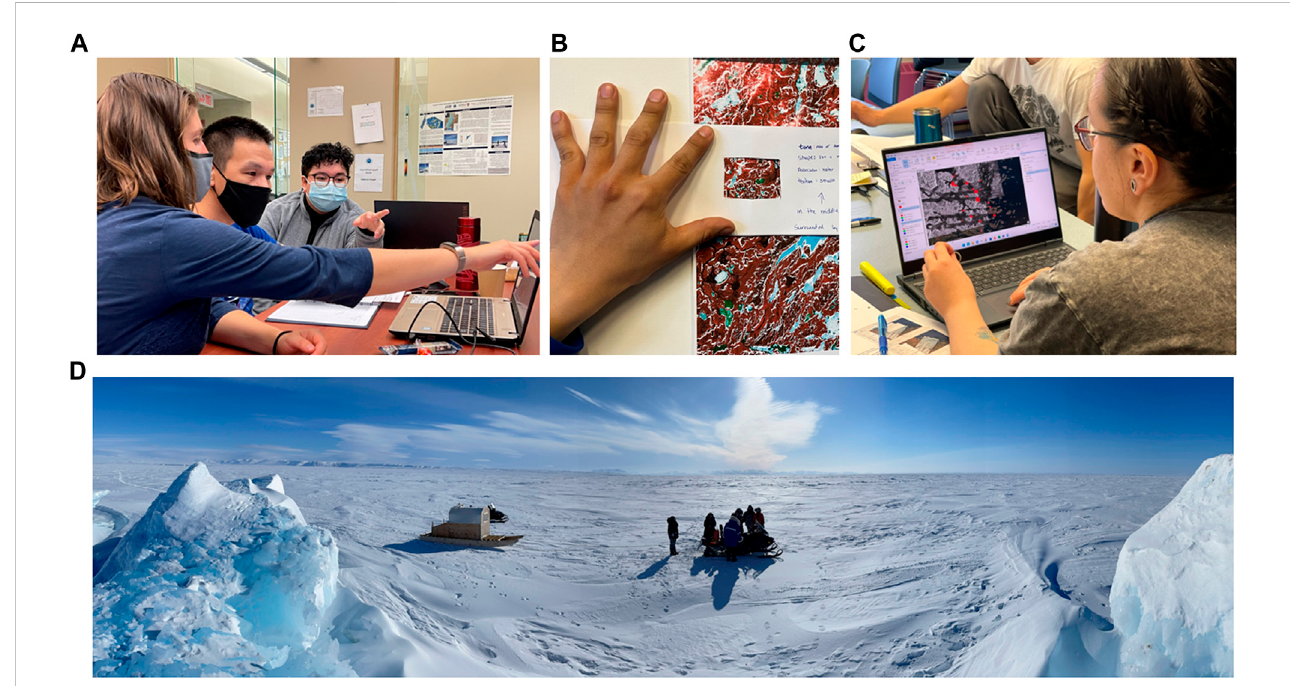
FIGURE 1 In-person workshops consisted of (A) . GIS training and mentoring, (B) . Hands-on remote sensing learning activities, (C) . Team exercises in cartography and (D) . In situ sea-ice learning and ground truthing of radar and optical